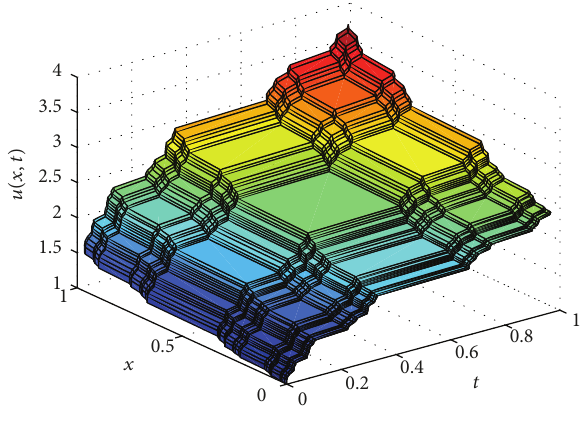
Figure 2: Plot of 𝑢(𝑥,𝑡) with the parameters 𝛼 = ln 2/ ln 3 and 𝑘 = 50